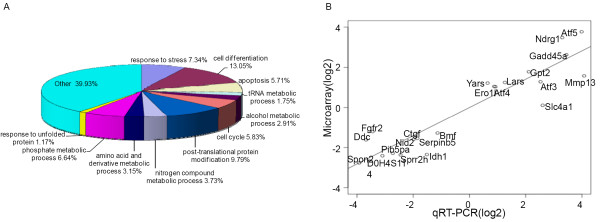
Global expression profiling implicates multiple biological pathways downstream of HF. (A) Relative abundance of HF transcriptional targets based on biological ontogeny. Biological processes which accounted for one percent or more and p < 0.001 are specifically shown. Note that stress response and unfolded protein response characteristic genes are among those showing enrichment. Enrichment analysis was performed using The Database for Annotation, Visualization and Integrated Discovery (DAVID) v6.7. (B) Validation plot showing high correlation between array results and validation by quantitative RT-PCR. Fold-change values of 21 genes from the microarray (y-axis) are plotted against the corresponding values from the qRT-PCR (x-axis). Each value is the log2-ratio of the treated vs. the untreated samples. The slope of the regression line is 0.704 and the Pearson correlation coefficient is 0.938 (p-value 1.33e-11), indicating highly significant agreement.